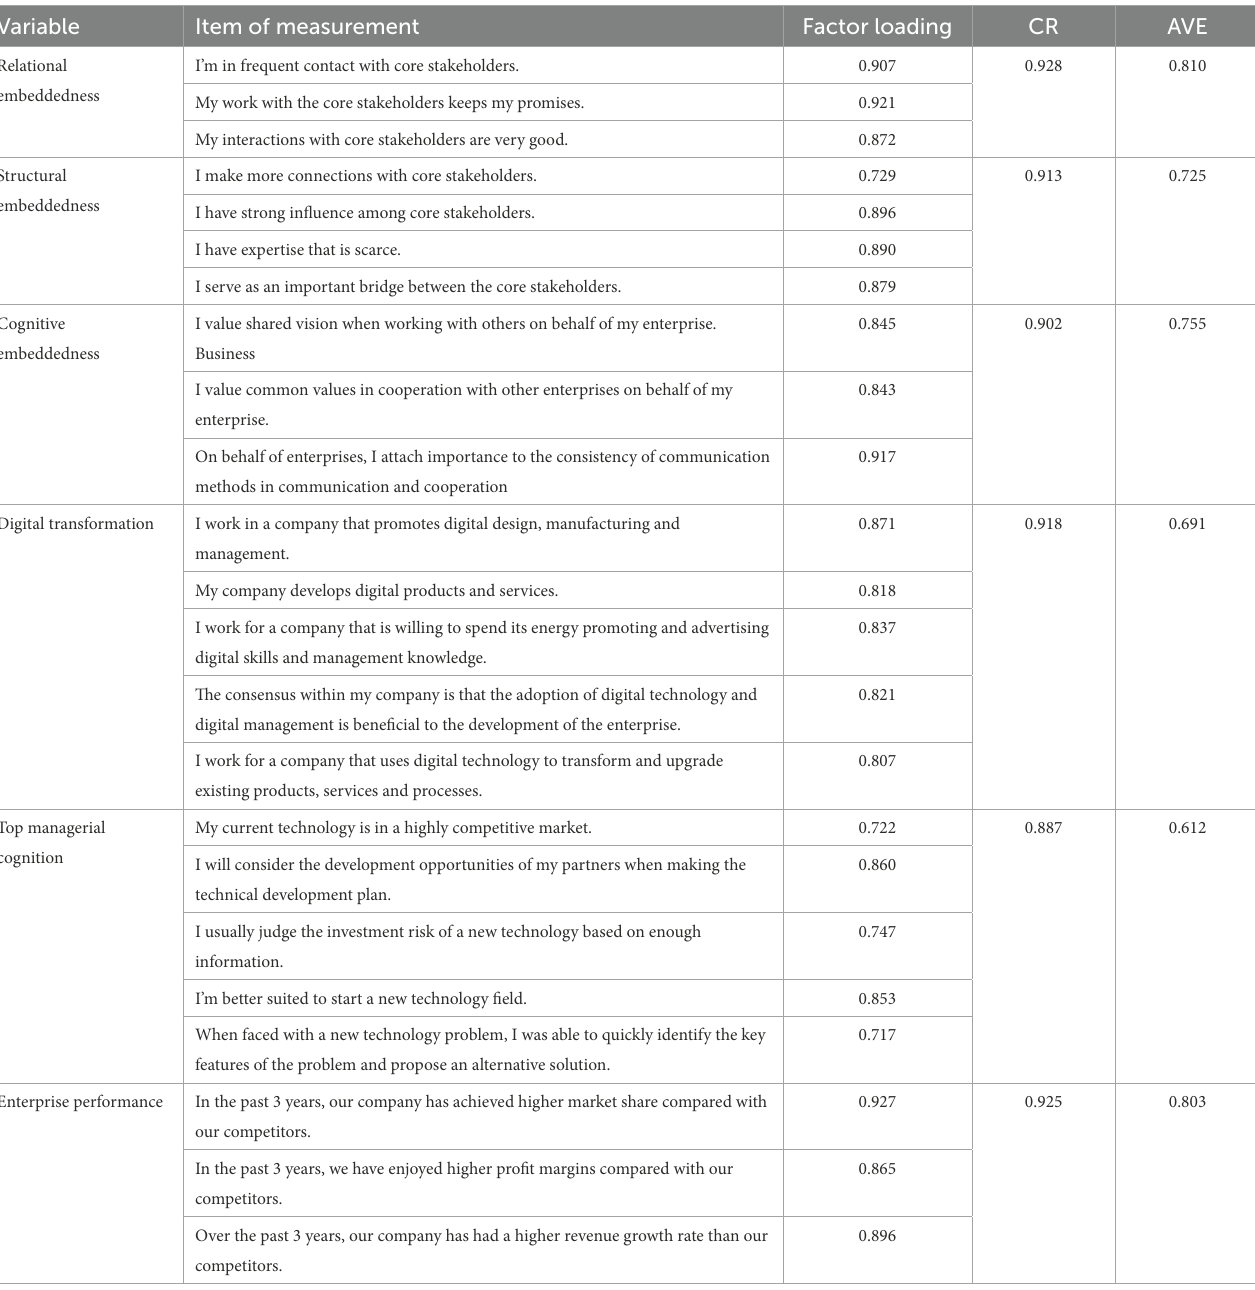
TABLE 1 Test of convergence